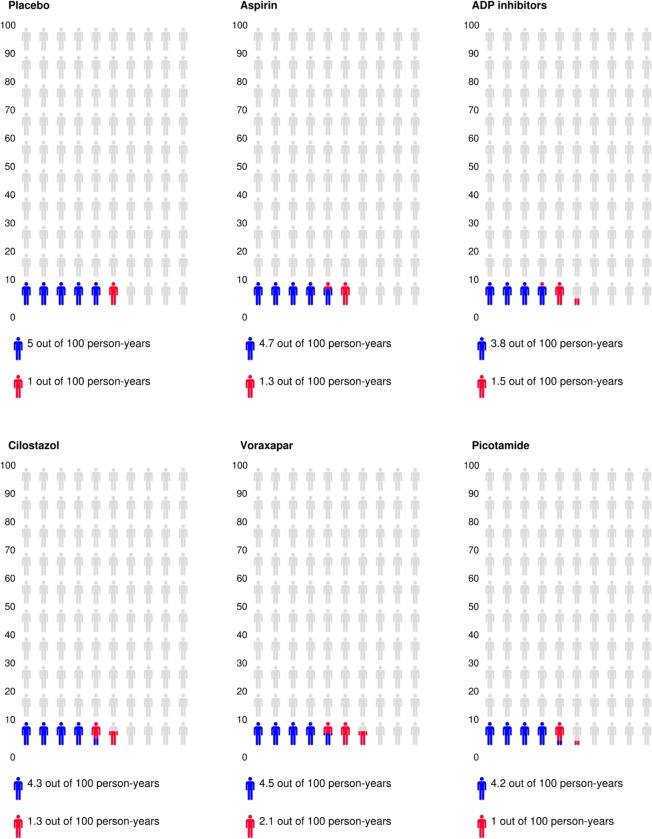
Icon arrays of absolute event rates.Icon arrays showing composite absolute event rates of MACE (blue) and severe bleeding (red) for different classes of antiplatelet agents in PAD patients. Results based on Bayesian fixed effects modelling of the secondary condensed class-level network of evidence.